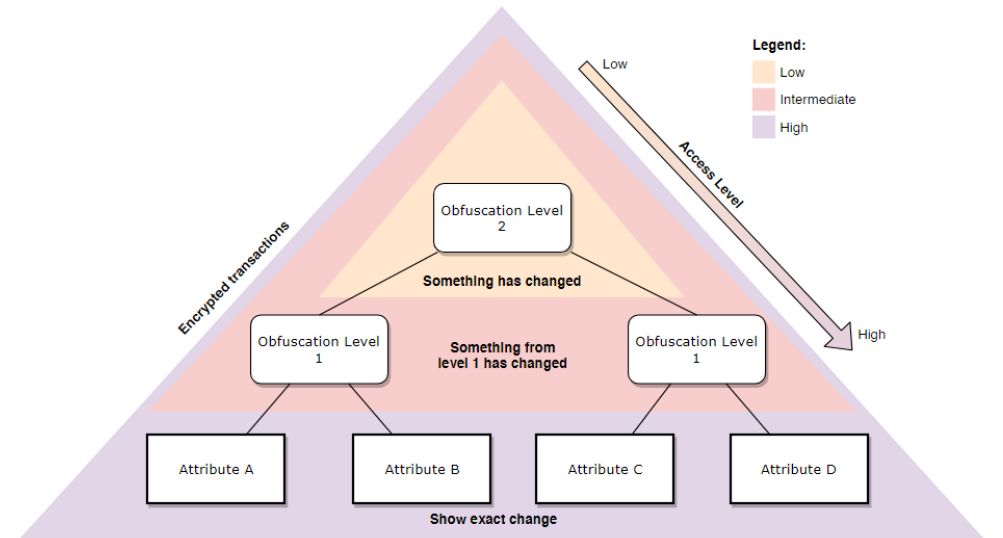
Figure 4: Different level of observers get a different level of view of the encrypted transaction. A Physician may get highest access and can see the change in gender, credit reference agency get intermediate access and can see a category change while any sort of details will be hidden from the public with visibility to undelaying